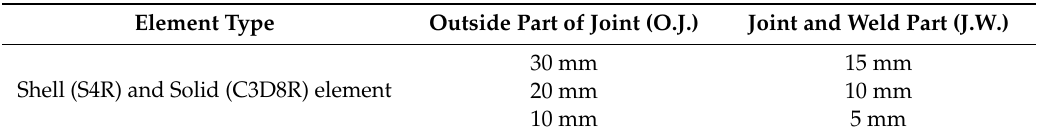
Table 4. Plan of mesh convergence study.